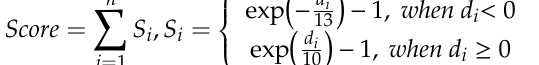
proposed method; ( b ) the median by the proposed method.